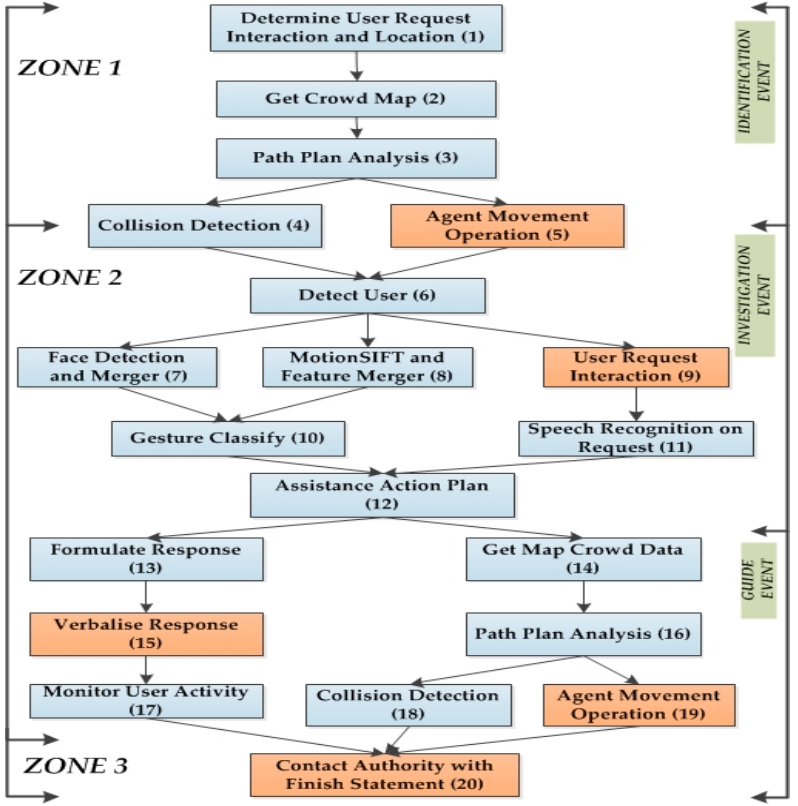
Figure 2. An operation task flow of smart city crowd control.